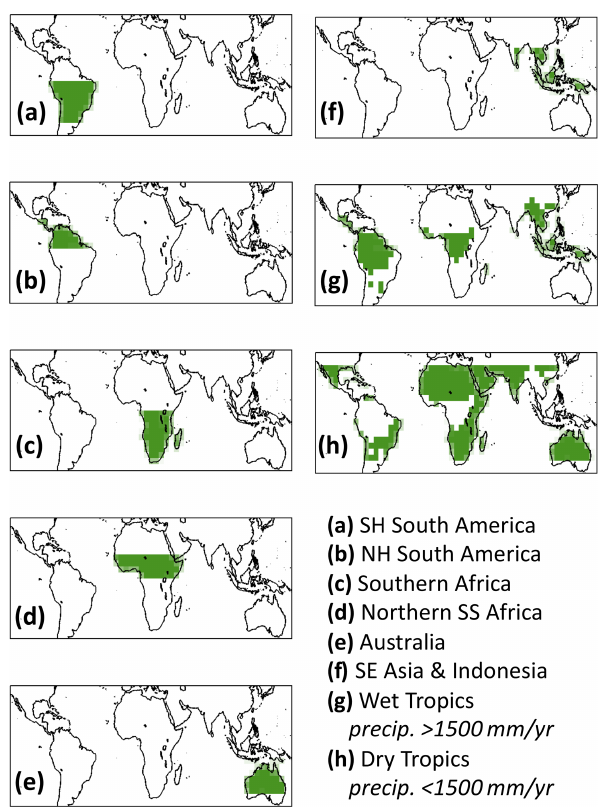
Figure A1. Regional masks used in this study. The 1500mmyr − 1 precipitation thresholds were based on the ERA-Interim mean annual precipitation rates throughout the 2001–2015 study